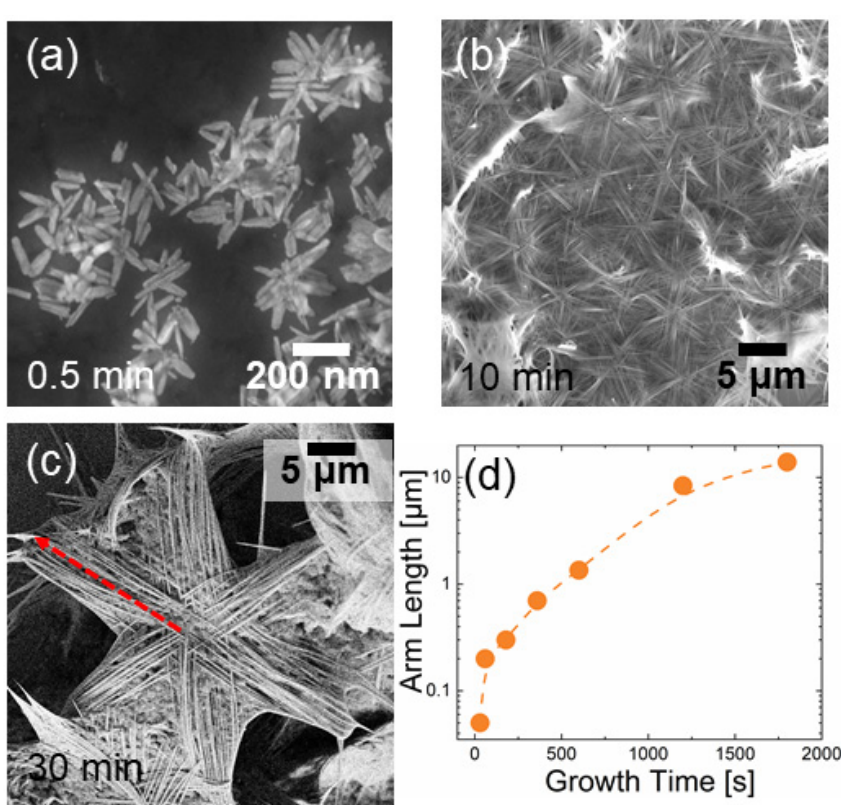
Figure 1. Kinetic study of ZnO NS growth. SEM images of nanostructures sampled after a growth of 0.5 ( a ), 10 ( b ), and 30 min ( c ); distribution of arm length as a function of time ( d ). The dashed red line in ( c ) indicates the arm length of an NS.